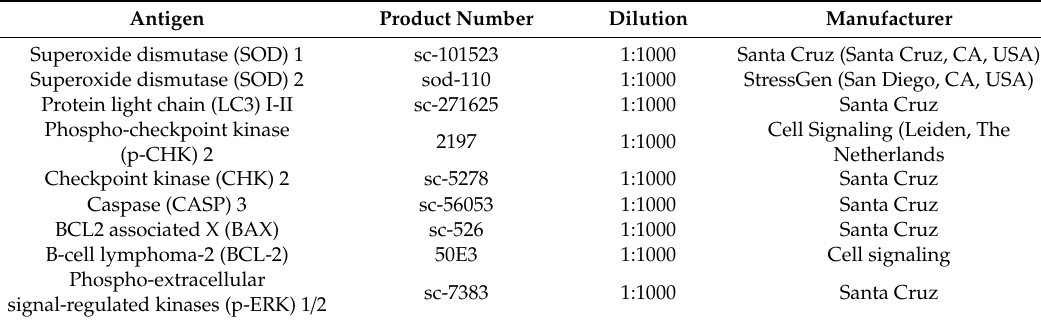
Table 1. List of primary antibodies